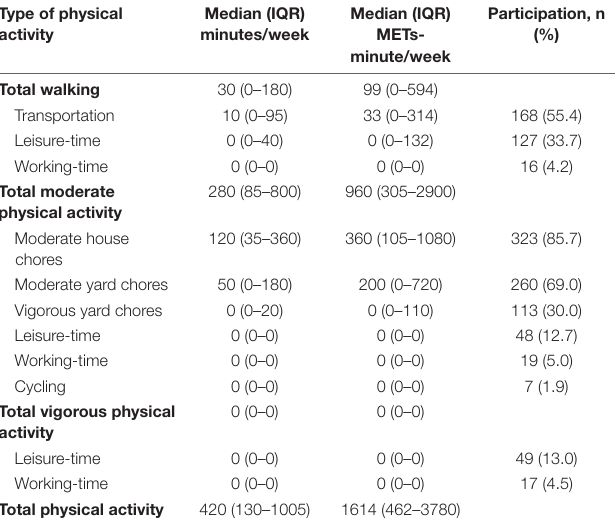
TABLE 5 | Physical activity values of the teachers and participation of them in different types of physical activity. Type of physical